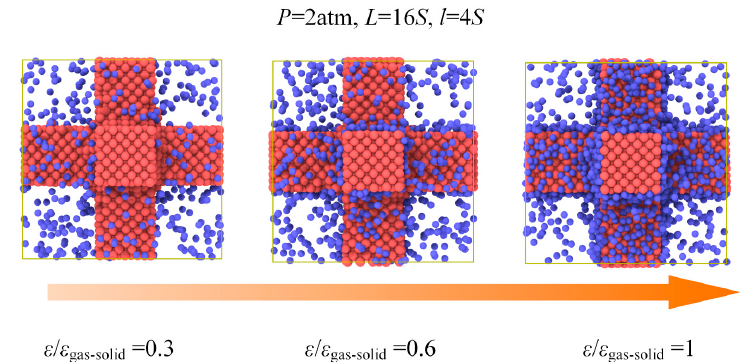
Figure 8. Gas atoms’ distribution for different ε under the pressure of 2 atm.